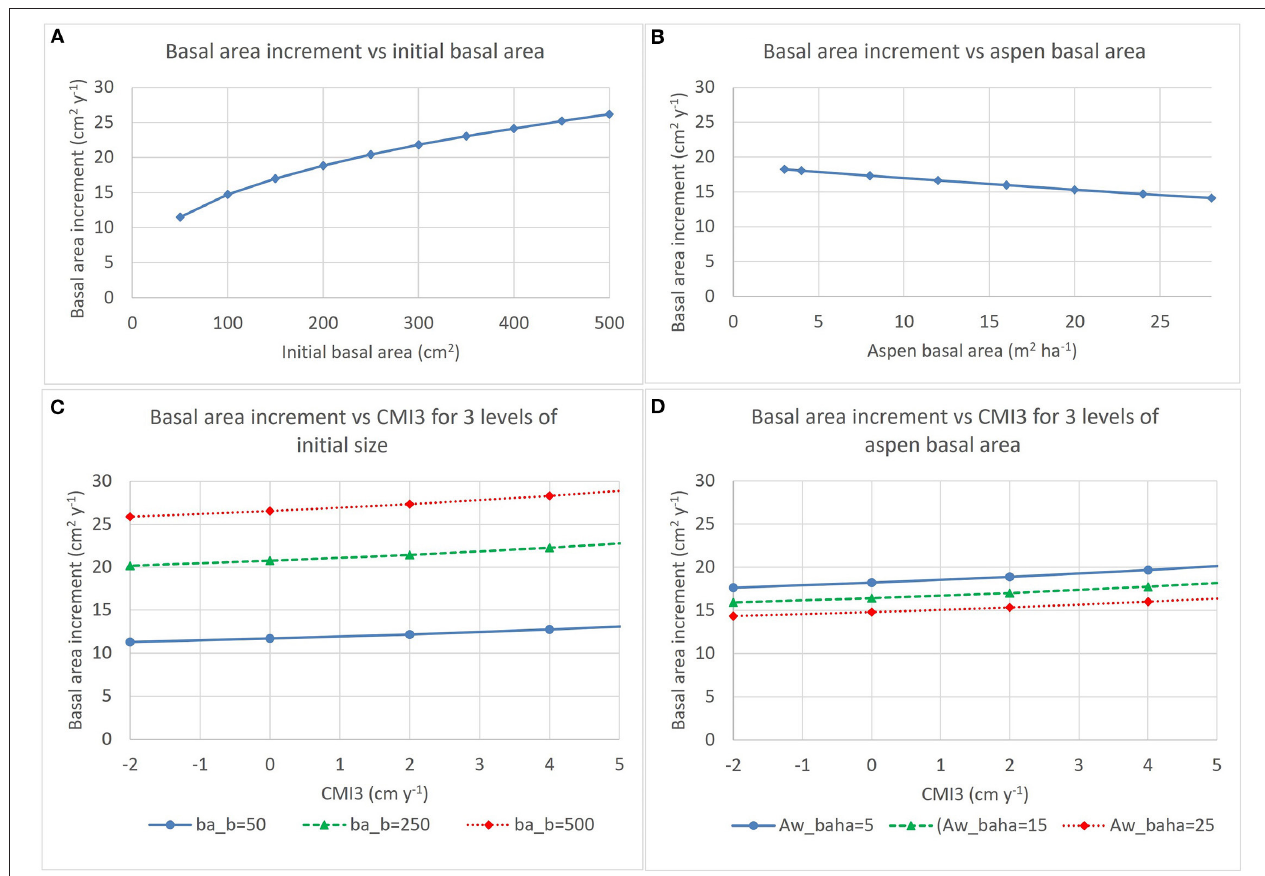
FIGURE 4 | Trends described by the model for annual basal area increment of aspen described in Table 4 . Effects of initial basal area and aspen basal area on basal area increment are shown in (A,B) , respectively. (C) Shows effects of interactions between CMI3 and initial basal area (ba_b) and (D) shows interaction between CMI3 and aspen basal area (Aw_baha) (for each panel, average values were used for all other variables in the